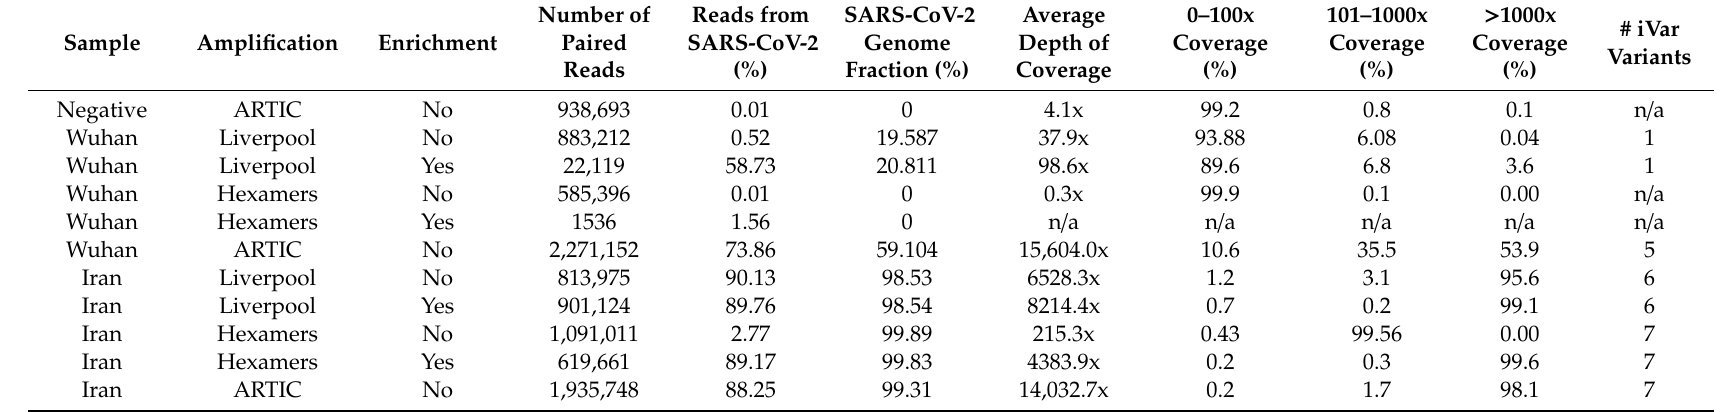
Table 1. Sequencing read and genome assembly statistics including the total raw read pairs obtained and fraction captured from SARS-CoV-2 RNA, the fraction of 29,903 bp MN908947.3 genome sequence covered, depth of coverage, and number of variants detected relative to MN908947.3.